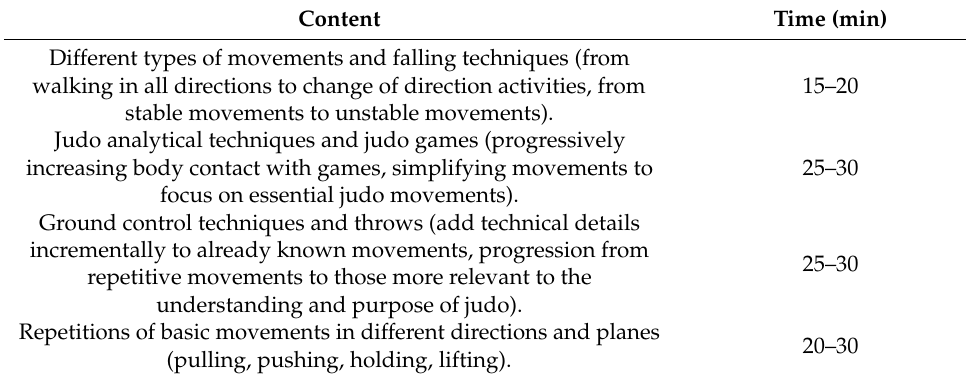
Table 1. Contents and temporal distribution of the adapted judo